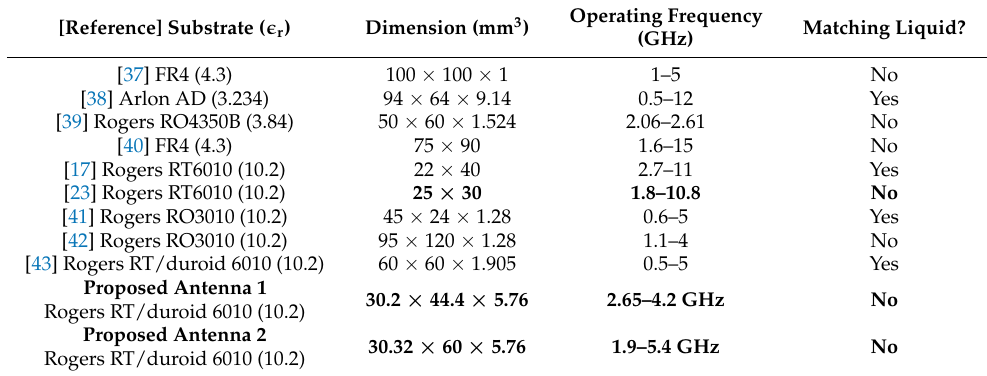
Table 1. Comparison of the proposed antennas with state-of-the-art Vivaldi